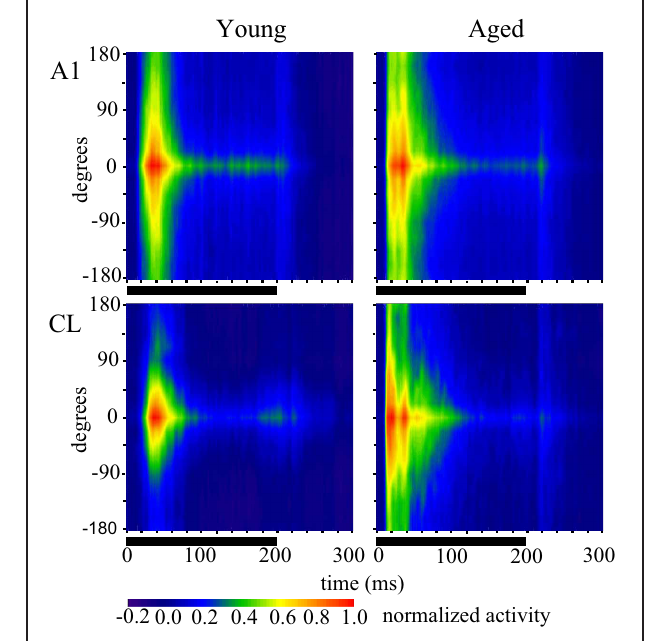
FIGURE 2 | Population response across time and spatial location. Each panel shows the response of the population of A1 (top) and CL (bottom) neurons in young animals (left) and aged animals (right). Warmer colors represent greater activity. The response period is shown as the solid line below each panel. Each neuron was normalized to the best direction at 0 along the y-axis, with leftward eccentricities below and rightward eccentricities above. Young animals showed an increase in spatial tuning between A1 and CL, as shown by less activity beyond about ± 90 ◦ . There was also more of a sustained response for the best direction compared to eccentric directions. Aged animals showed broader tuning in general, particularly in area CL, and a more oscillating response over